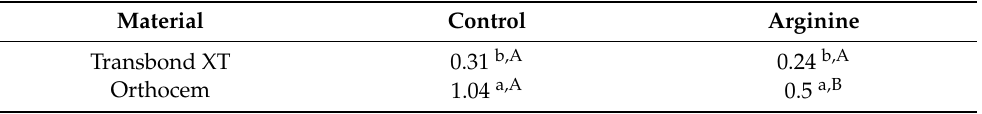
Table 4. Mean and standard deviation ( × 10 − 6 CFU/mL) for S. mutans after incubation with the tested materials.